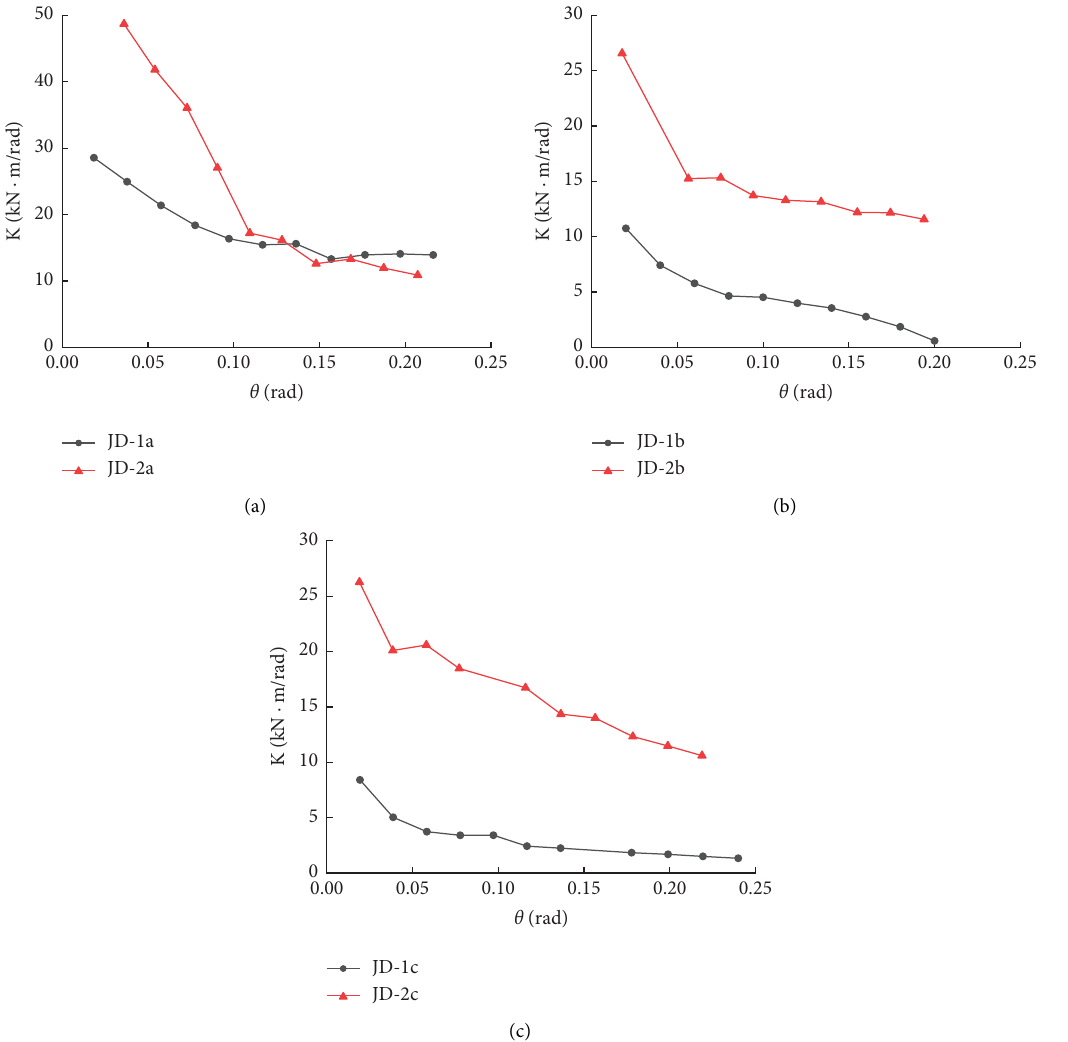
Figure 12: Curves of rigidity degradation: (a) Tou mortise-tenon joints. (b) Ban mortise-tenon joints. (c) Dovetail mortise-tenon joints.